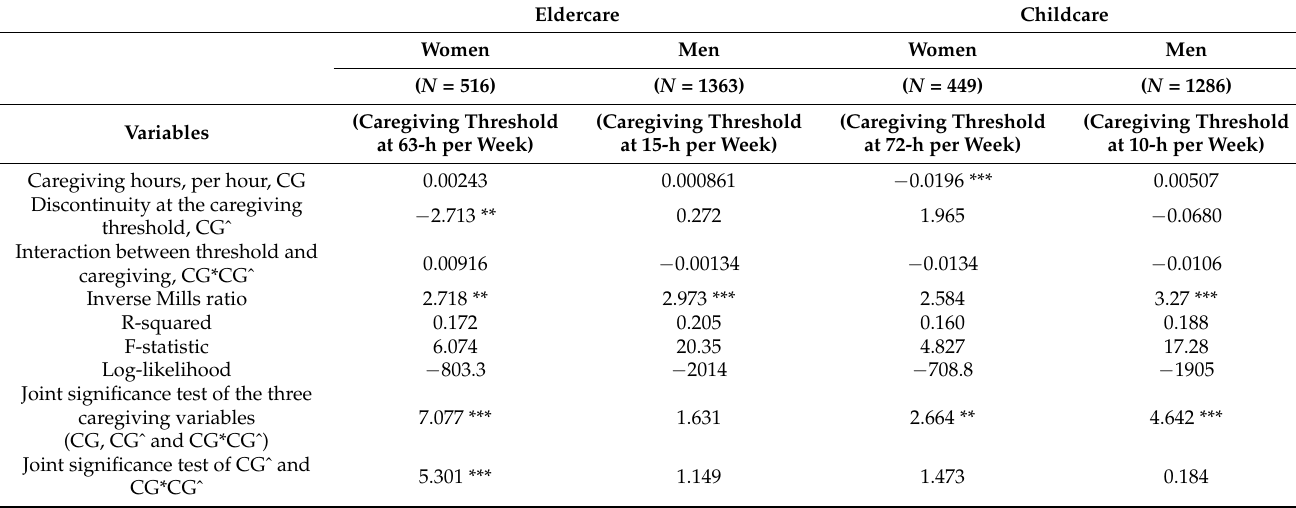
Table 4. Results of separate Heckman selection modeling procedures for eldercare and childcare. Eldercare